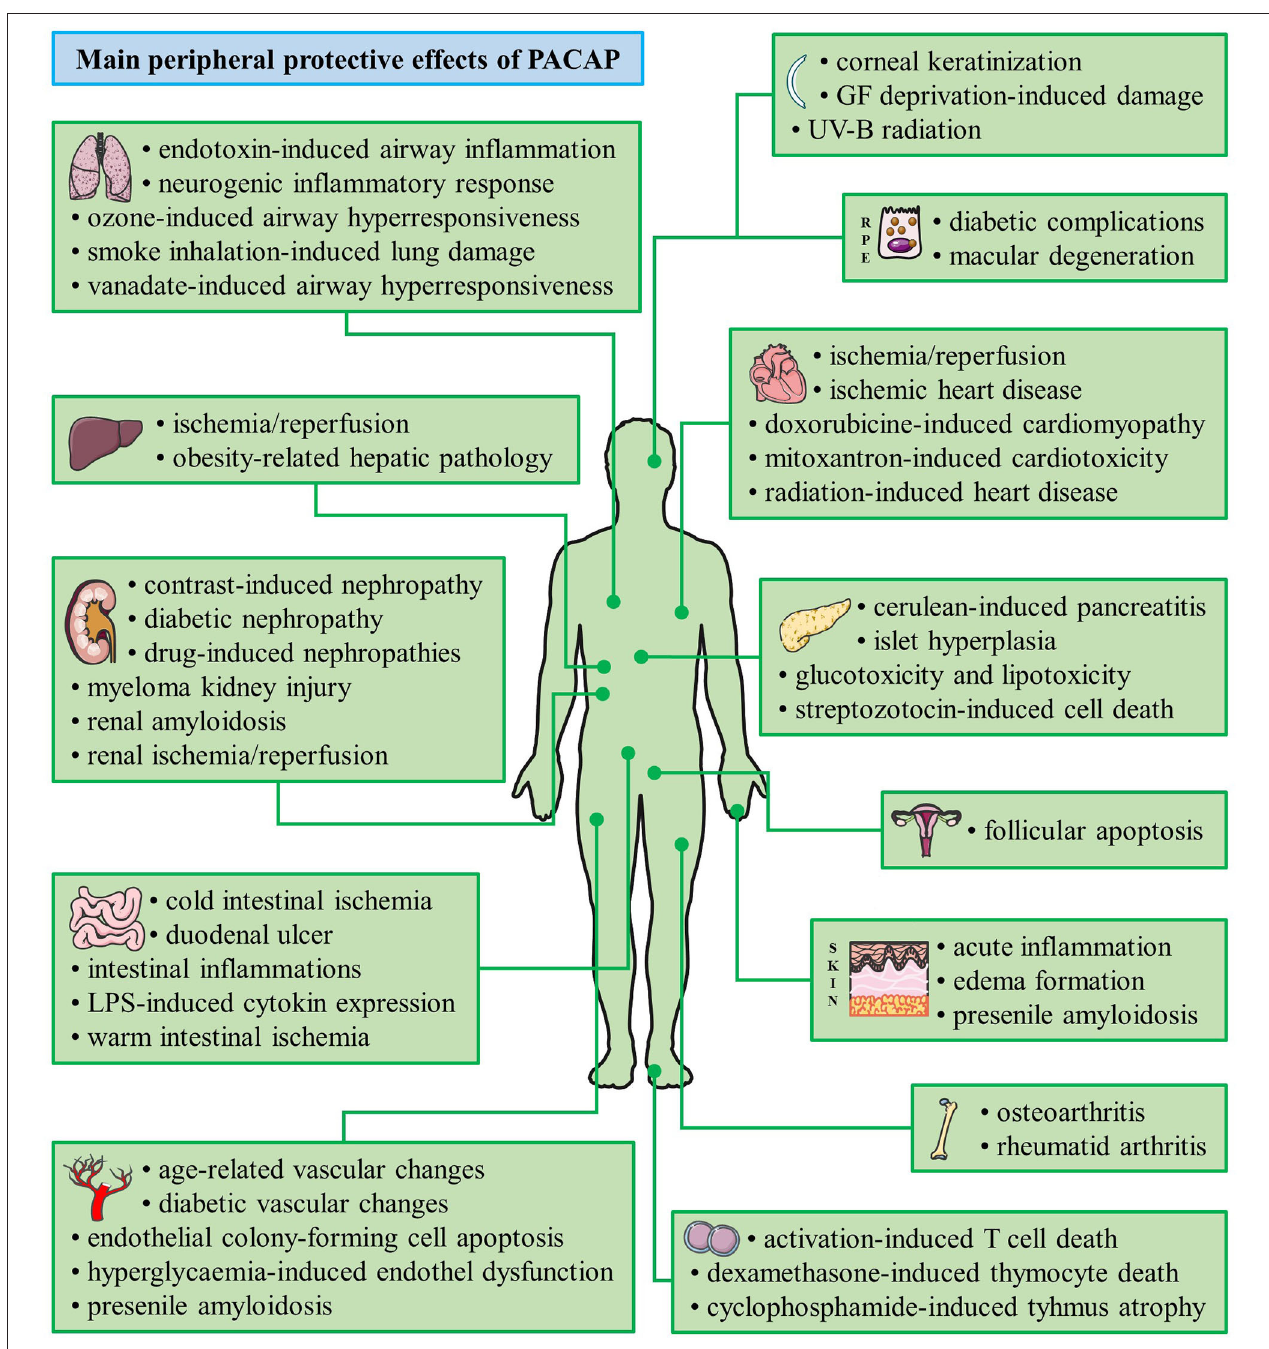
FIGURE 1 | Summary of the main cytoprotective effects of PACAP. (Graphics are adapted from Servier Medical Art under a Creative Commons Attribution 3.0 Unported License.)